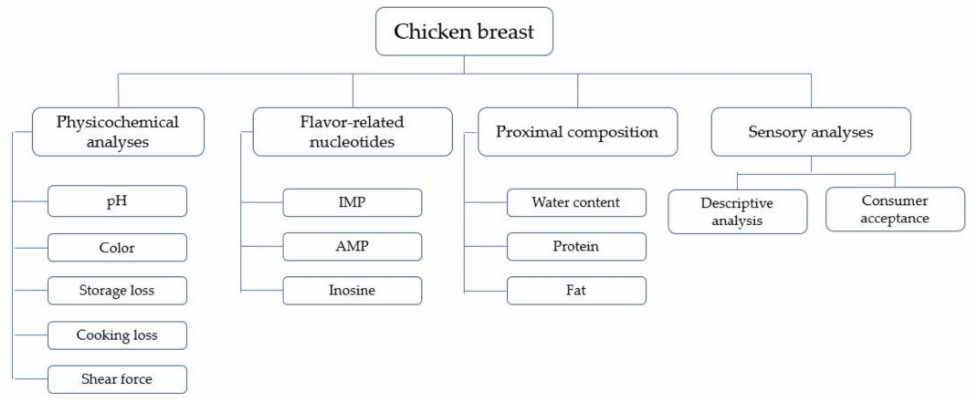
Figure 1. Scheme of the sample